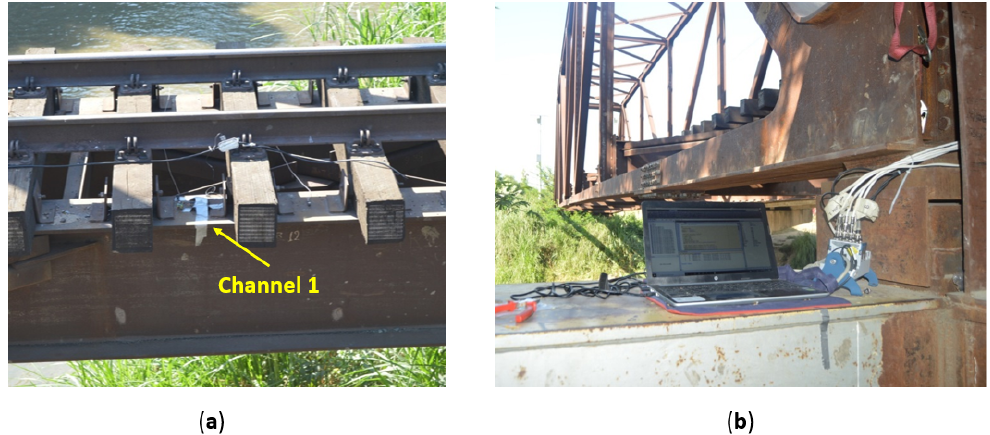
Figure 10. Railway bridge monitoring: ( a ) Location of measurement channel 1. ( b ) Base station of